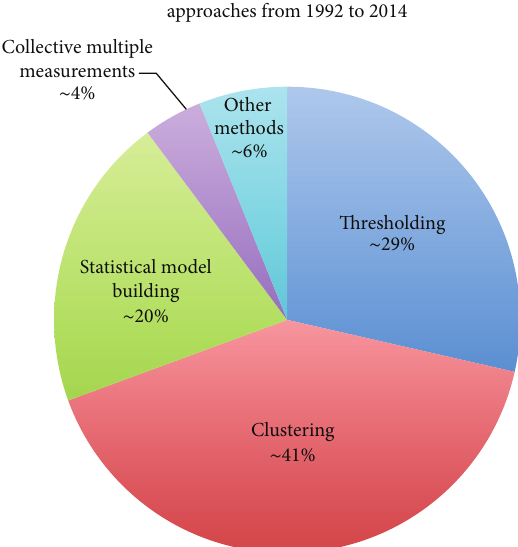
Figure 4: Distribution of mammographic density segmentation using 2D projection based